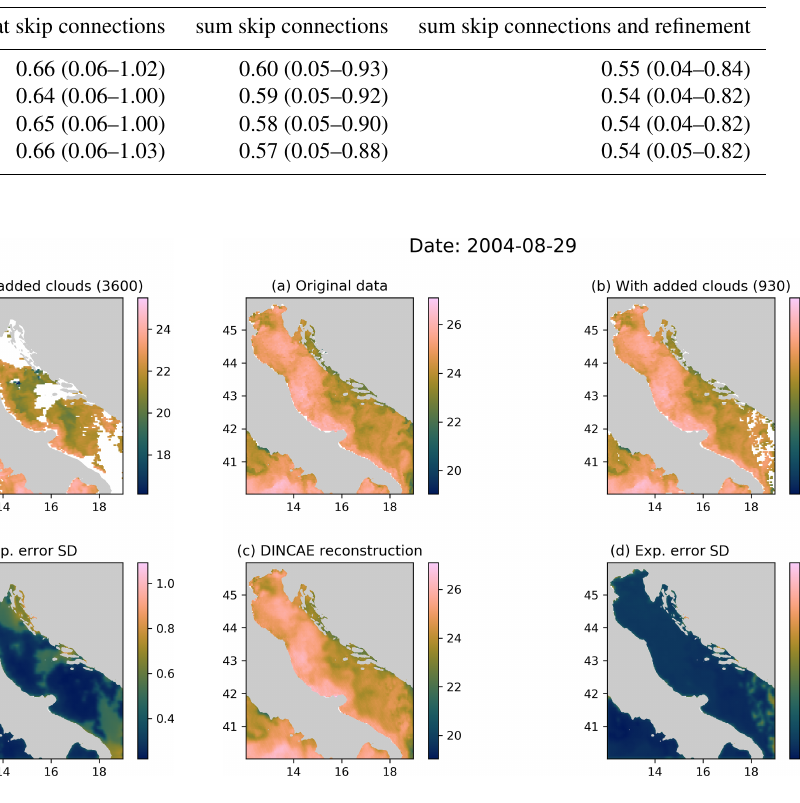
Figure 5. (a) The original MODIS SST; (b) MODIS SST with ad- ditional clouds for cross-validation; (c) the DINCAE reconstruction using the data from panel (b) ; (d) the expected error standard devi- ation of the DINCAE reconstruction. All panel values are in ◦